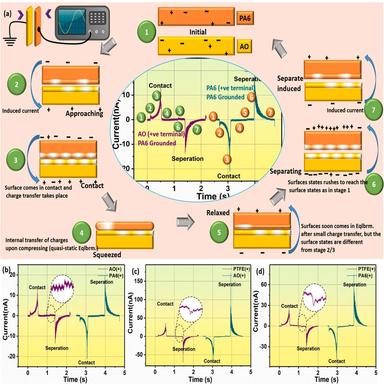
The illustration of the individual electrical signals during the contact electrification cycle. (a) The contact electrification cycle is classified into 6 different steps of materials from approaching to separation. (b-d) Signal identification using single electrode feature of various combinations (b) AO/PA6 device (c) PTFE/AO device (d) PTFE/PA6 device. The inset shows the zoomed portion of the date on the onset of stage 5.